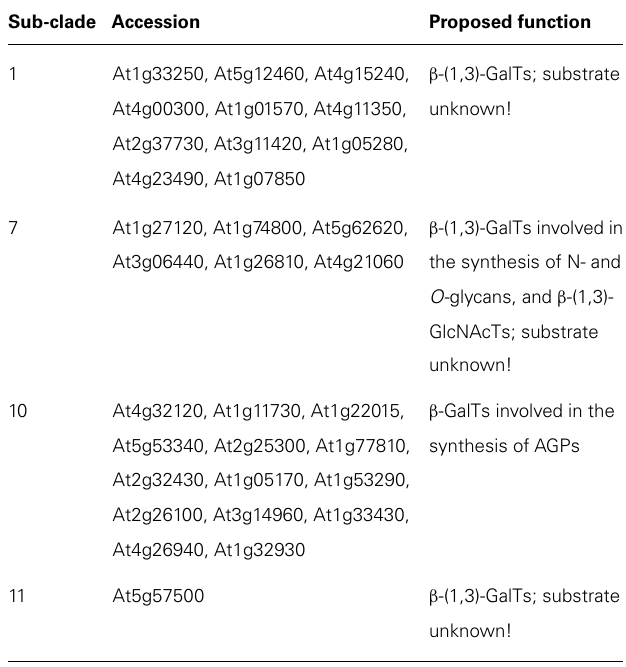
Table 2 |The 31 putative GalTs from the Arabidopsis thaliana CAZy GT-family-31 and their proposed